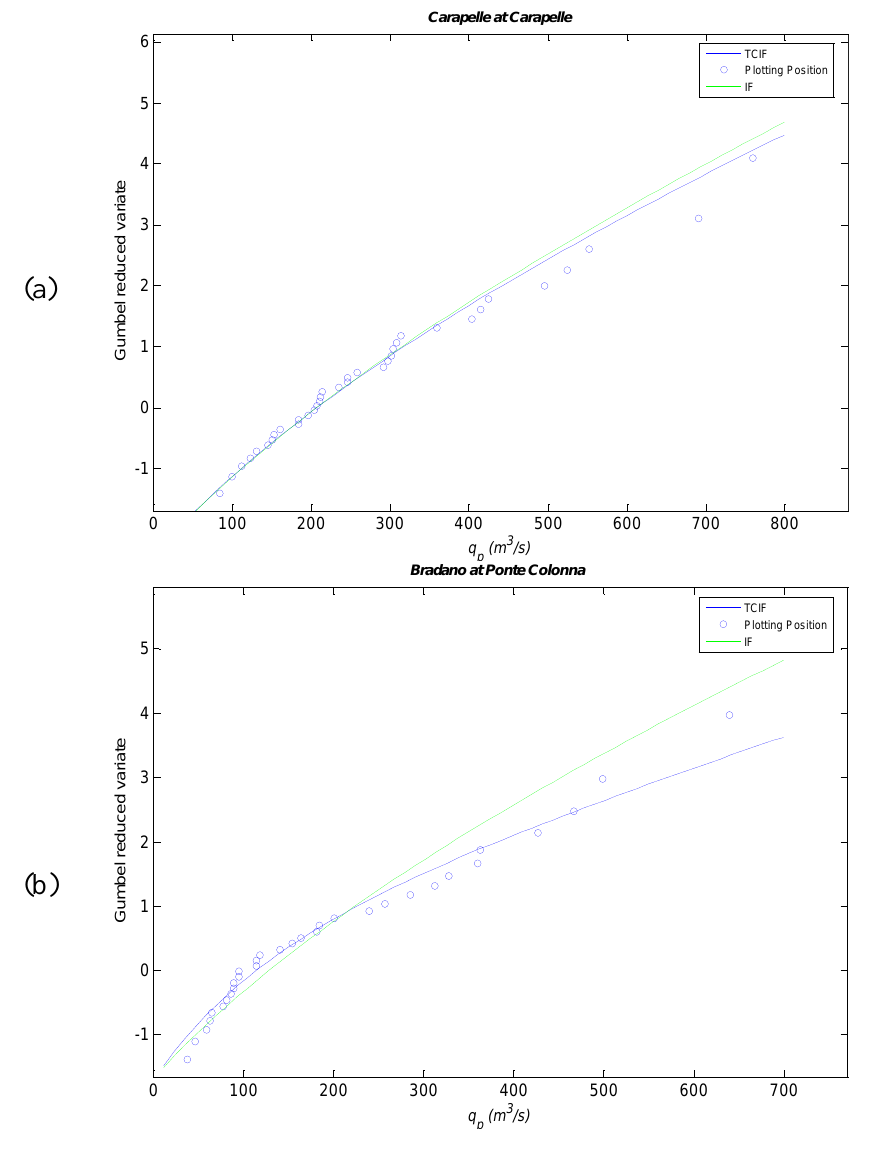
Figure 2. Comparison between TCIF and IF CDFs and the Weibull plotting positions of the annual maximum flood series: (a) Carapelle at Carapelle and (b) Bradano at Ponte